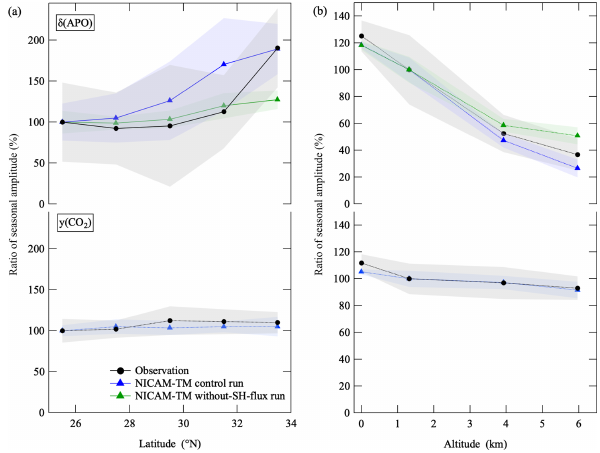
Figure 8. (a) Latitudinal distribution of average ratios of the ob- served seasonal δ (APO) and CO 2 amount fraction amplitudes cal- culated relative to the values observed at 25.5 ◦ N in the troposphere over the western North Pacific throughout the observation period (black filled circles). Error bands (shaded) indicate year-to-year variations ( ± 1 σ ). The corresponding results calculated using the NICAM-TM control run (blue triangles) and the without-SH-flux run (green triangles) are also shown. Amplitude of seasonal APO cycle was calculated as a difference between an average value dur- ing July to September and that during February to April considering its broad peak, while that of CO 2 amount fraction was evaluated as a difference between seasonal maximum and minimum values. (b) Same as in (a) but for vertical distribution over MNM relative to the corresponding values at 1.3km, and amplitude of seasonal APO cycle was evaluated as a difference between an average value during July to October and that during February to April. The av- erage fractions of surface seasonal cycles obtained from continuous observations of δ (O 2 / N 2 ) and the CO 2 amount fraction at MNM since December 2015 and the corresponding results calculated us- ing NICAM-TM control run are also